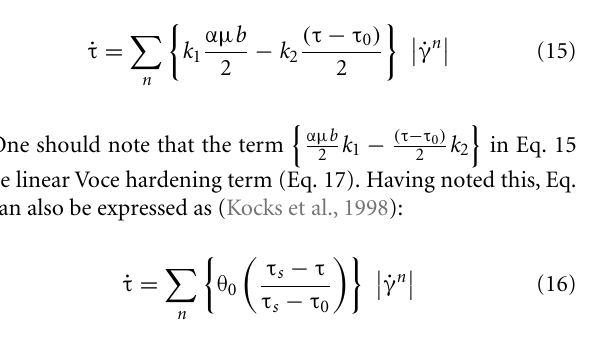
From Eq. 11, the following identity is obtained for the